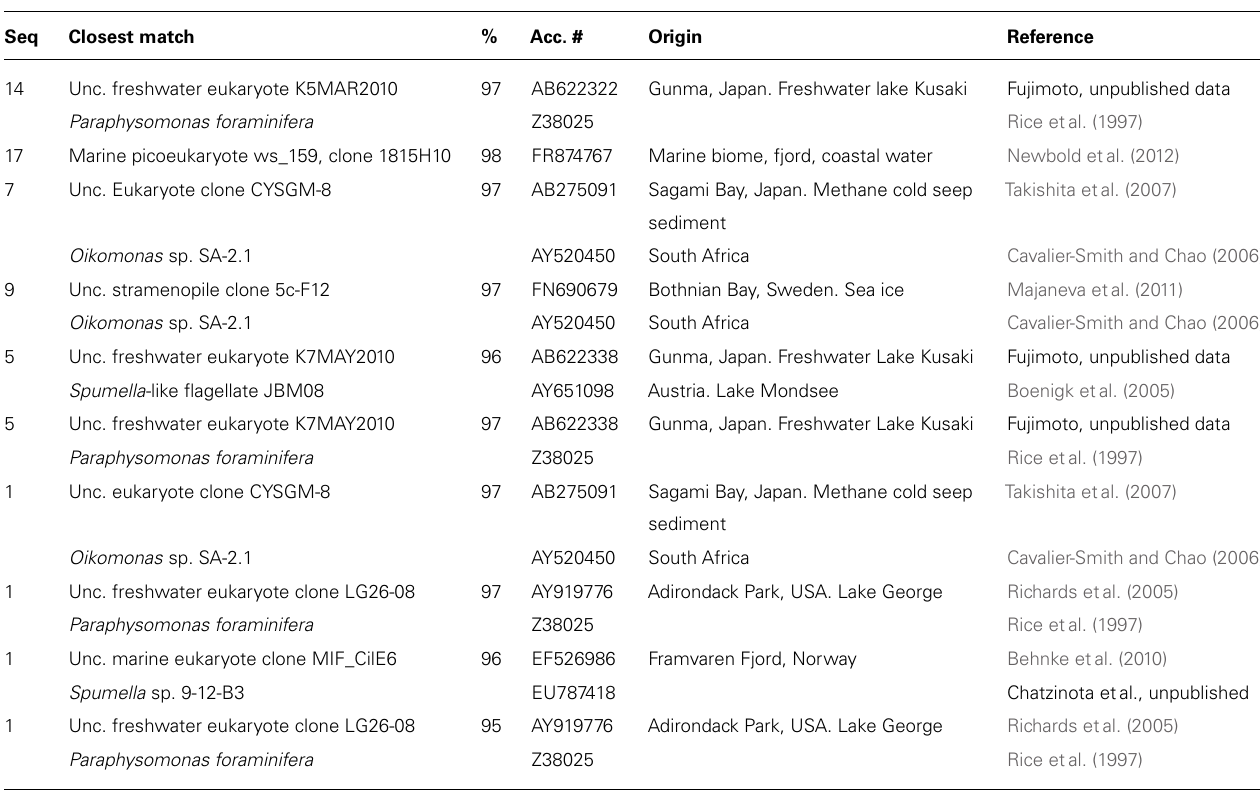
Table 4 | BLAST search results for unclassified chrysophyte sequences in the 12 m sample from May 2008. Seq Closest match % Acc.